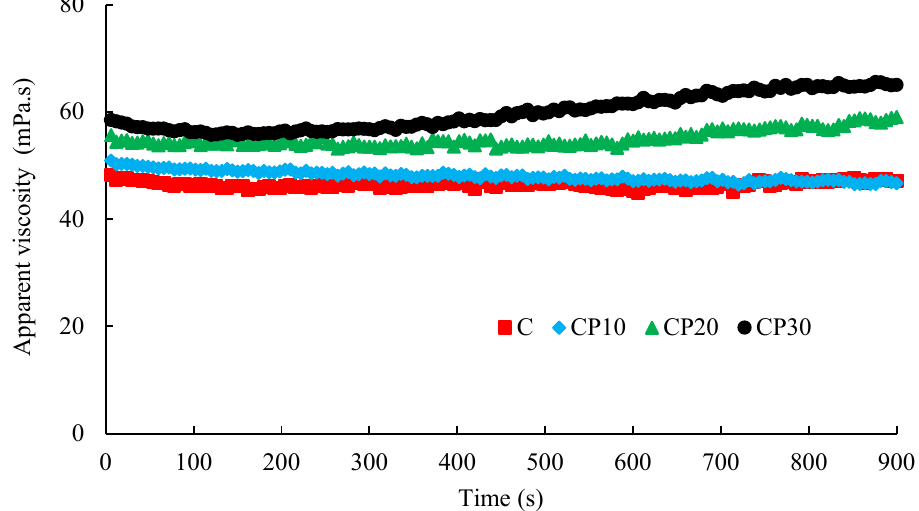
Figure 5. Changes in the apparent viscosity of different BSG dispersions (0.3%) at a constant shear rate of 50 s − 1 as a function of temperature; C, CP 10 , CP 20 , and CP 30 indicate unmodified samples and those treated by CP for 10, 20, and 30 min, respectively. Filled and open symbols represent heating and cooling steps, respectively.